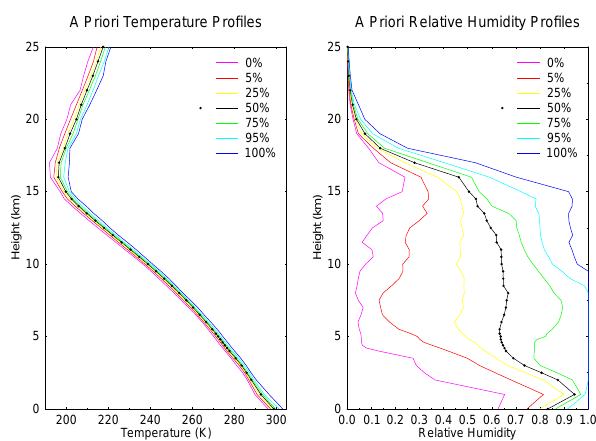
Fig. 3. Profiles of temperature and relative humidity from seven per- centiles in the a priori cumulative distribution